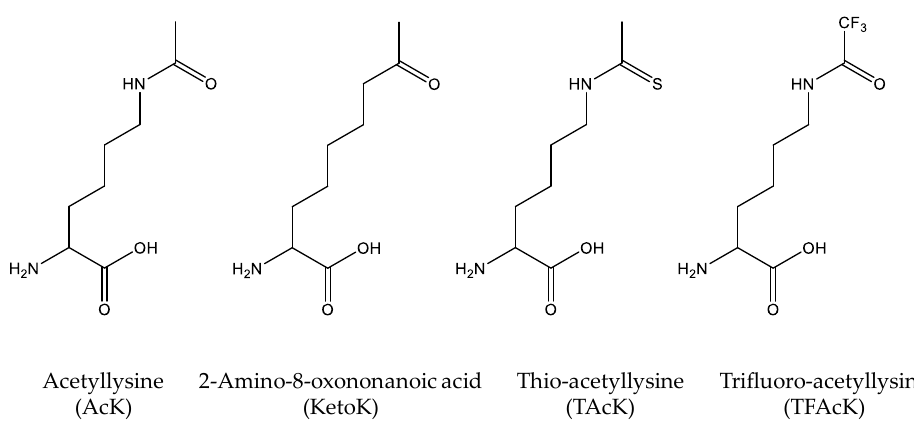
Figure 2. The Structures of acetyllysine (AcK) and its non-deacetylatable analogs, including 2-amino-8-oxononanoic acid (KetoK), thio-acetyllysine (TAcK) and trifluoro-acetyllysine (TFAcK).